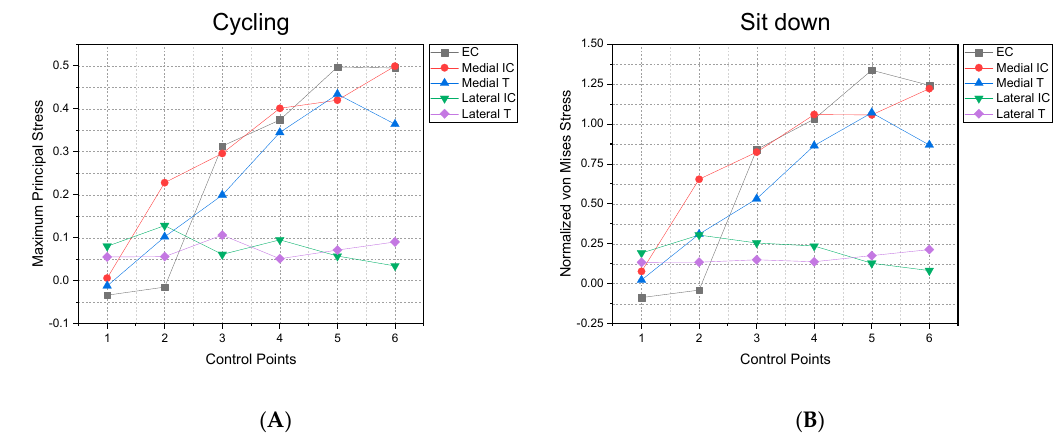
Figure 8. Maximum principal stresses occurring at the control points when applying ( A ) cycling and ( B ) sitting-down loads.